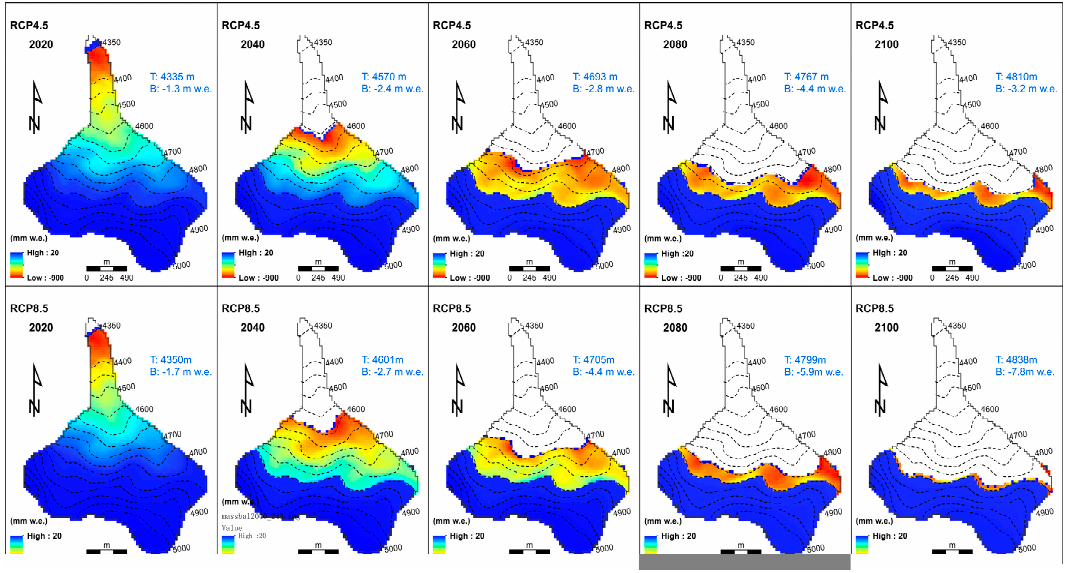
Figure 14. The terminus elevation and SMB distribution of Qiyi glacier under the RCP 4.5 and RCP 8.5 climate scenarios. The bold blue T refers to the terminus elevation; the bold blue B refers to the glacier-wide SMB. Dash lines and numbers refer to the elevation band of the Qiyi glacier.